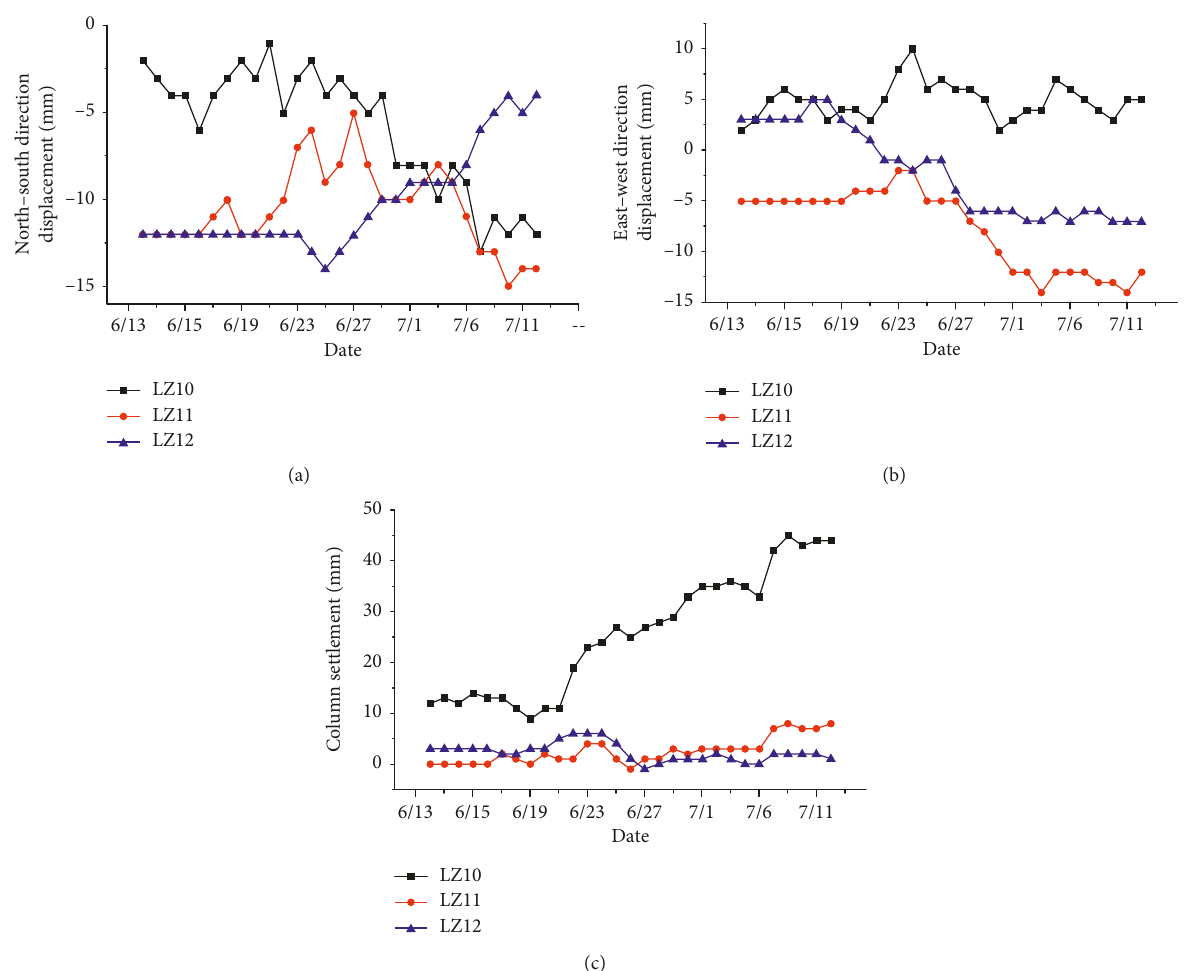
Figure 9: Monitoring data of site. (a) North-south horizontal displacement. (b) East-west horizontal displacement. (c) Column